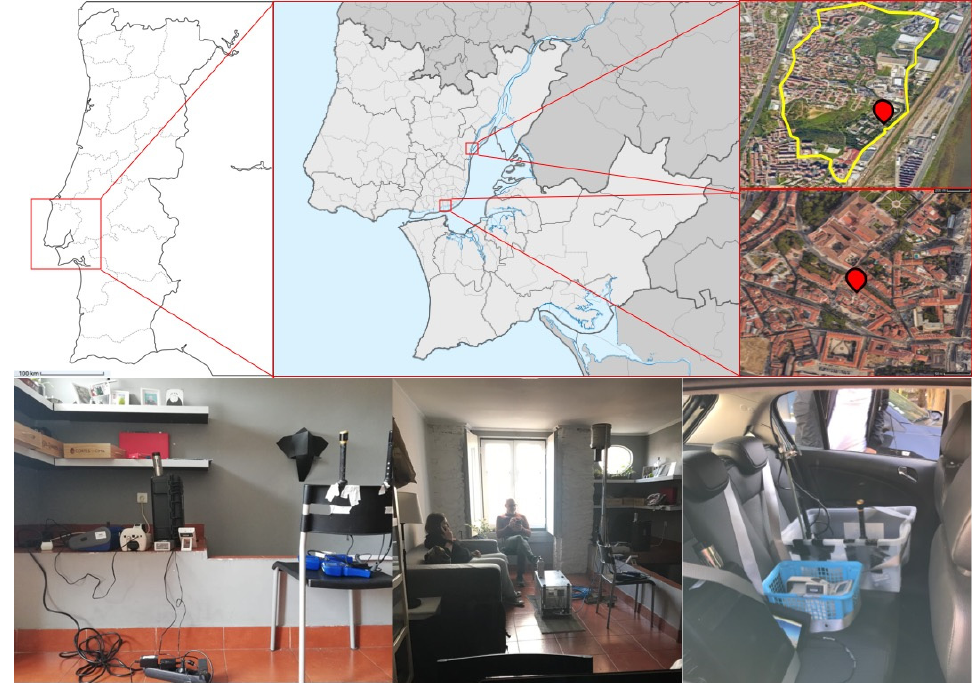
Figure 1. Top: measurement locations within the Lisbon metropolitan area (Portugal)—car route in Loures municipality (right, top) and location of the studied flat in Lisbon municipality (right, middle). Bottom: arrangement of the measuring instruments in the home (left and center) and car (right).